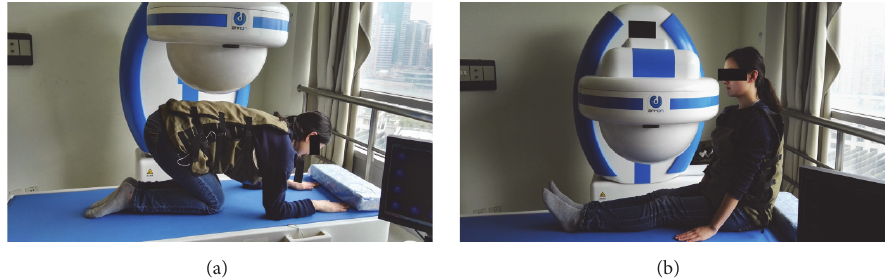
Figure 2: Demonstration of KC and Si positions. (a) KC position. (b) Si position. KC: knee-chest; Si: sitting.